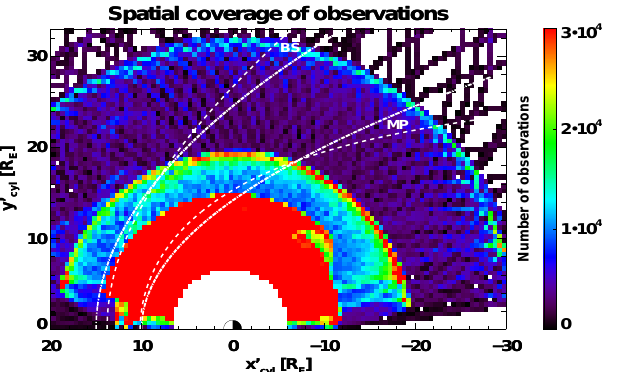
Fig. 3. Spatial coverage of the THEMIS wave intensity observa- tions displayed in Fig. 2 with the same bow shock (BS) and magne- topause (MP) models. The spatial coverage is inhomogeneous due to a better coverage of observations close to Earth. Nonetheless, sufficient observations within a radius of ∼ 30 R E are available.